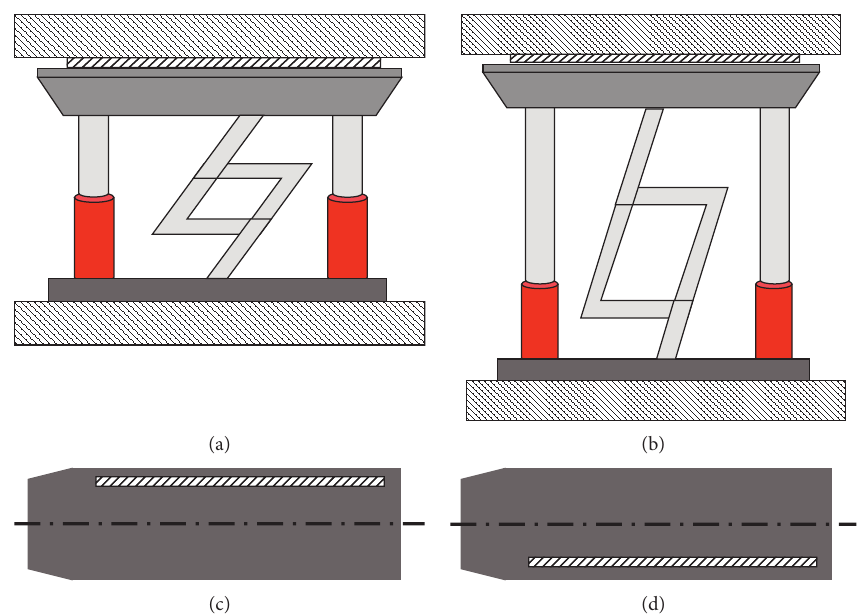
Figure 5: Loading diagram and block position. (a) Top beam at the low position. (b) Top beam at the high position. (c) The block at the left side of the top beam. (d) The block at the right side of the top